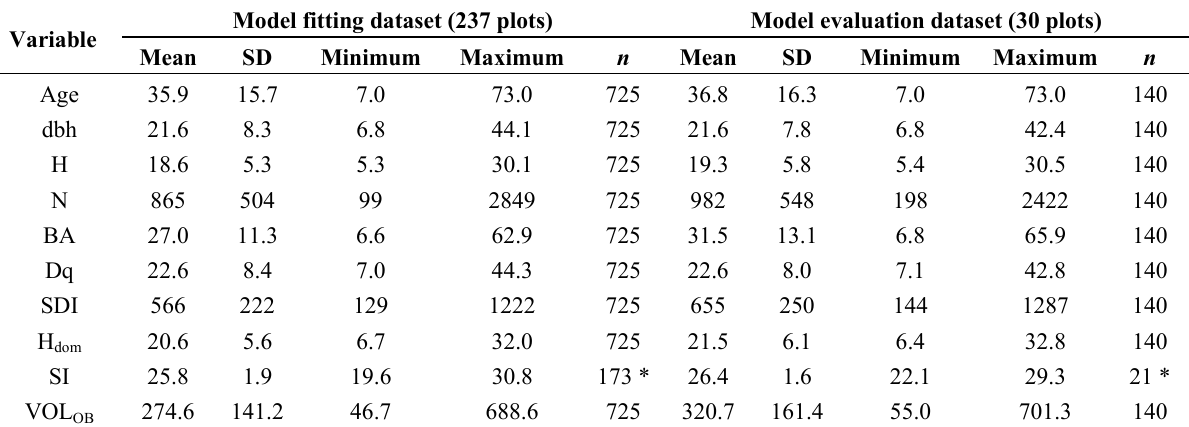
Table 1. Summary statistics and stand characteristics for 267 permanent longleaf pine plots measured (thinned and unthinned). Model fitting dataset (237 plots) Model evaluation dataset (30 plots) Variable